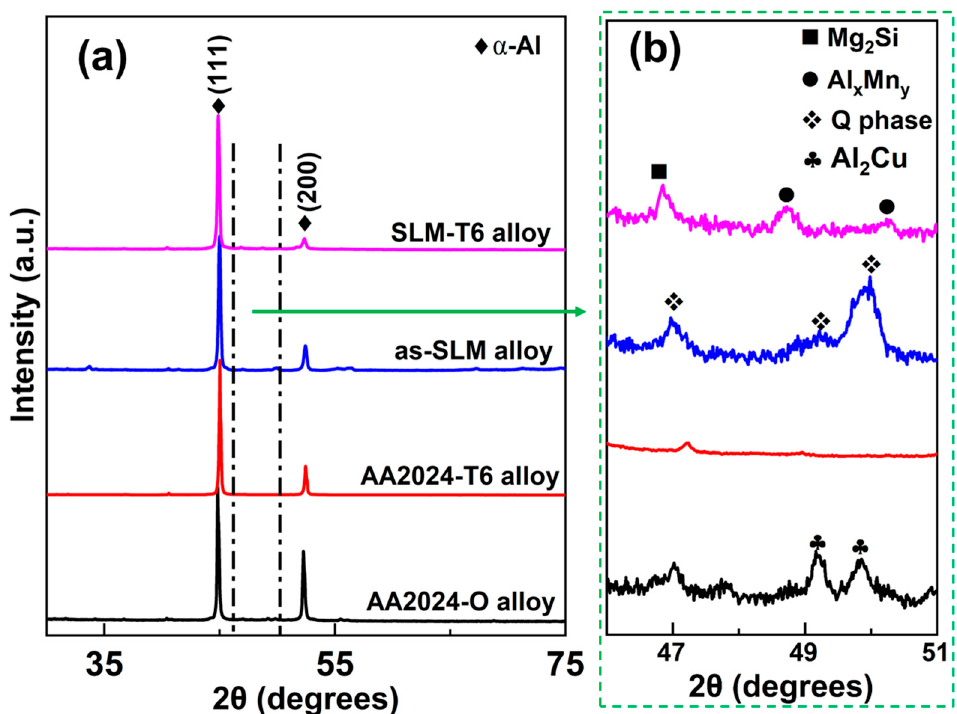
Figure 3. XRD patterns of the SLM Al-3.5Cu-1.5Mg-1Si alloy and of the commercial AA2024-O alloy with and without the T6 heat treatment: ( a ) Overview; and ( b ) close-up view of the diffraction patterns between 46° ≤ 2 θ ≤ 51°.